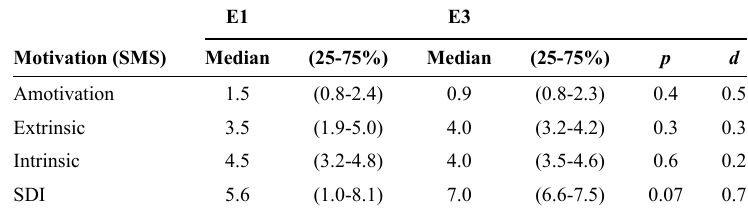
Table 3 - Comparison between the moments of assessment of motivational